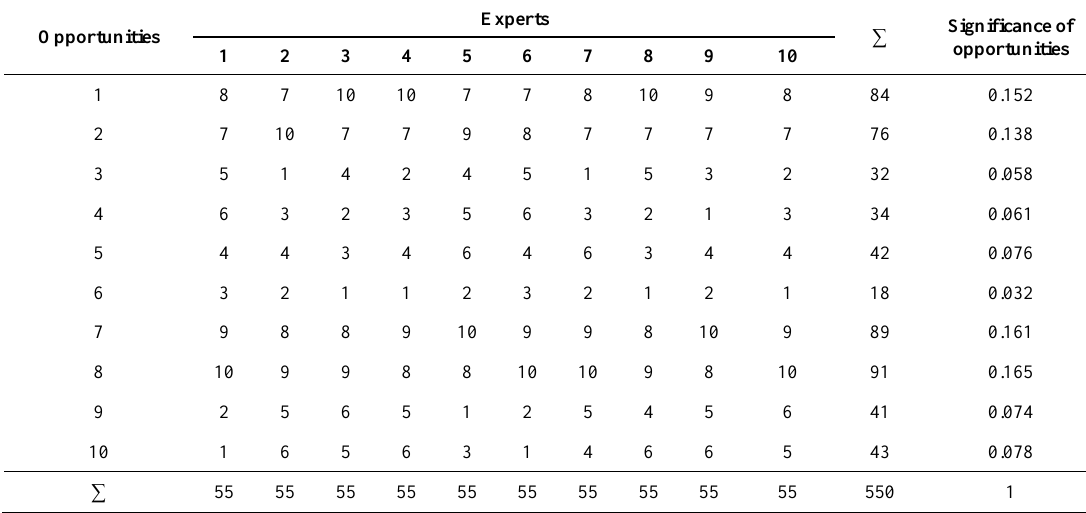
Table 2. Assessment of